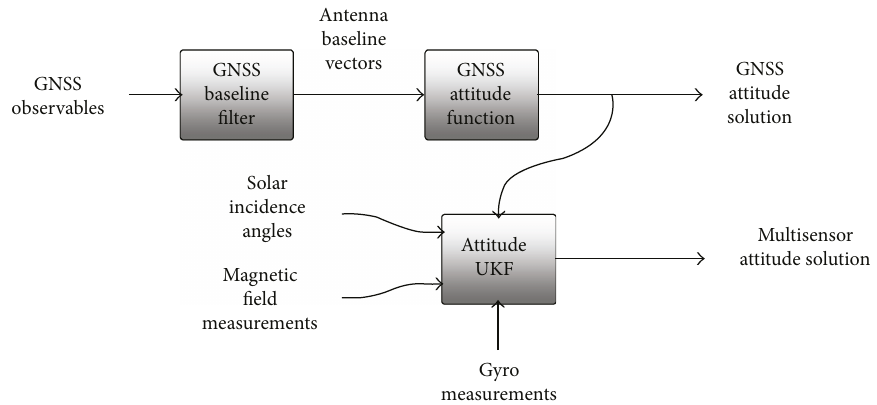
Figure 1: Block diagram showing the three main estimators: antenna baseline fi lter, GNSS-only attitude estimator, and multisensor attitude estimator. This fi gure is an updated version of what was presented in the conference paper version of this work